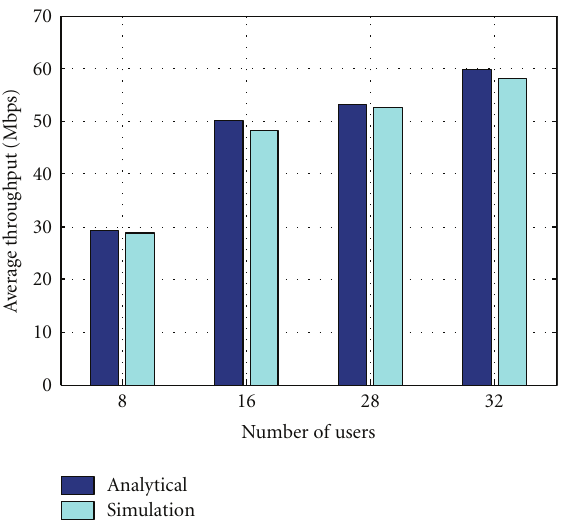
Figure 6: Average throughput versus number of users.